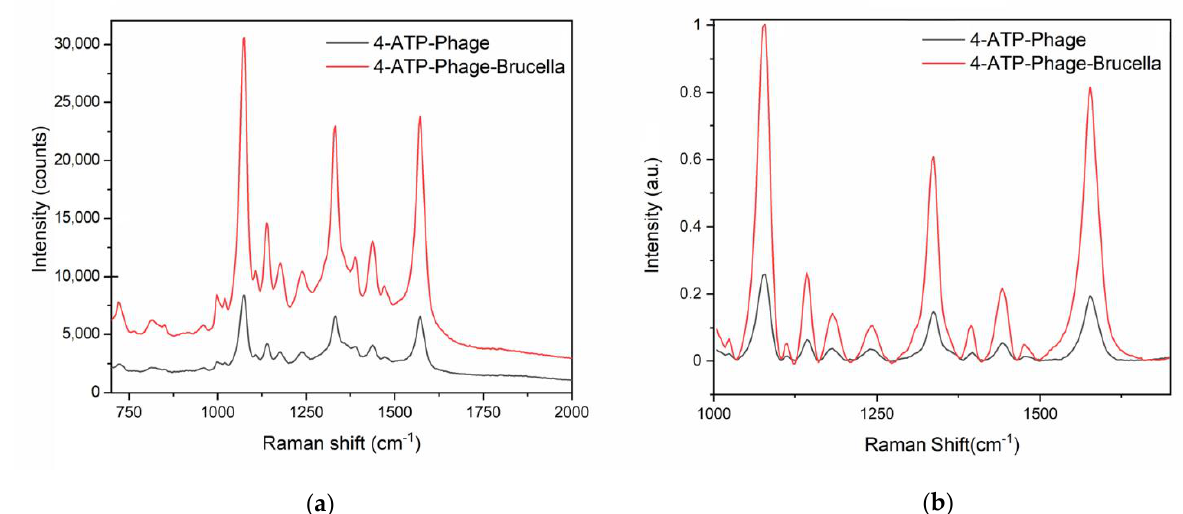
Figure 5. Comparison of SERS measurements performed on our functionalized nanostructures after binding in milk. ( a ) Registered SERS spectra of the covalently immobilized phage (black curve) and the captured Brucella. ( b ) Magnification of 40-min incubation of the Tb-sensor with milk free of pathogens (black line, Figure 5). Micro-filtrated milk was then inoculated with the live bacteria. The spiked sample (300 µL, total bacterial count of 3 × 10 4 CFU) was dispersed onto the biosensor surface and incubated for 40 min. The 1322 cm −1 peak recorded for the contaminated sample (red line, Figure 5b) had a 4-fold larger area than the reference peak of the negative control spectrum (black line, Figure 5b and Table 1). These results proved the outstanding performances of our biosensor in real conditions, i.e., with a viable form of the pathogen and a complex food matrix. Interesting to note, the signal amplification achieved for B. abortus detection in milk was even higher than in distilled water at equal bacterial count. A plausible reason for this discrepancy could lie in the pH/ionic strength values of the two environments that differently influenced the phage binding.